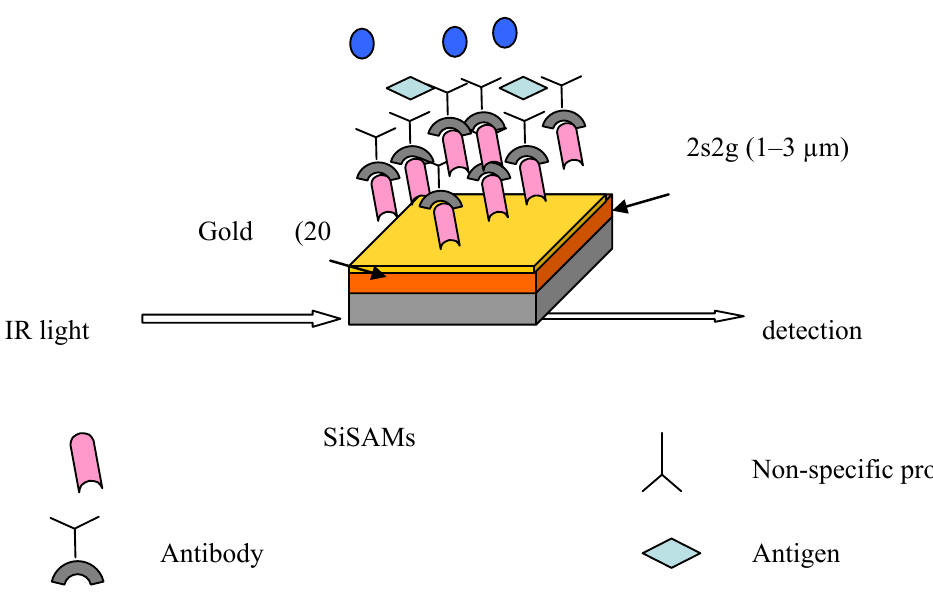
Figure 6. A schematic view of a functionalised 2s2g